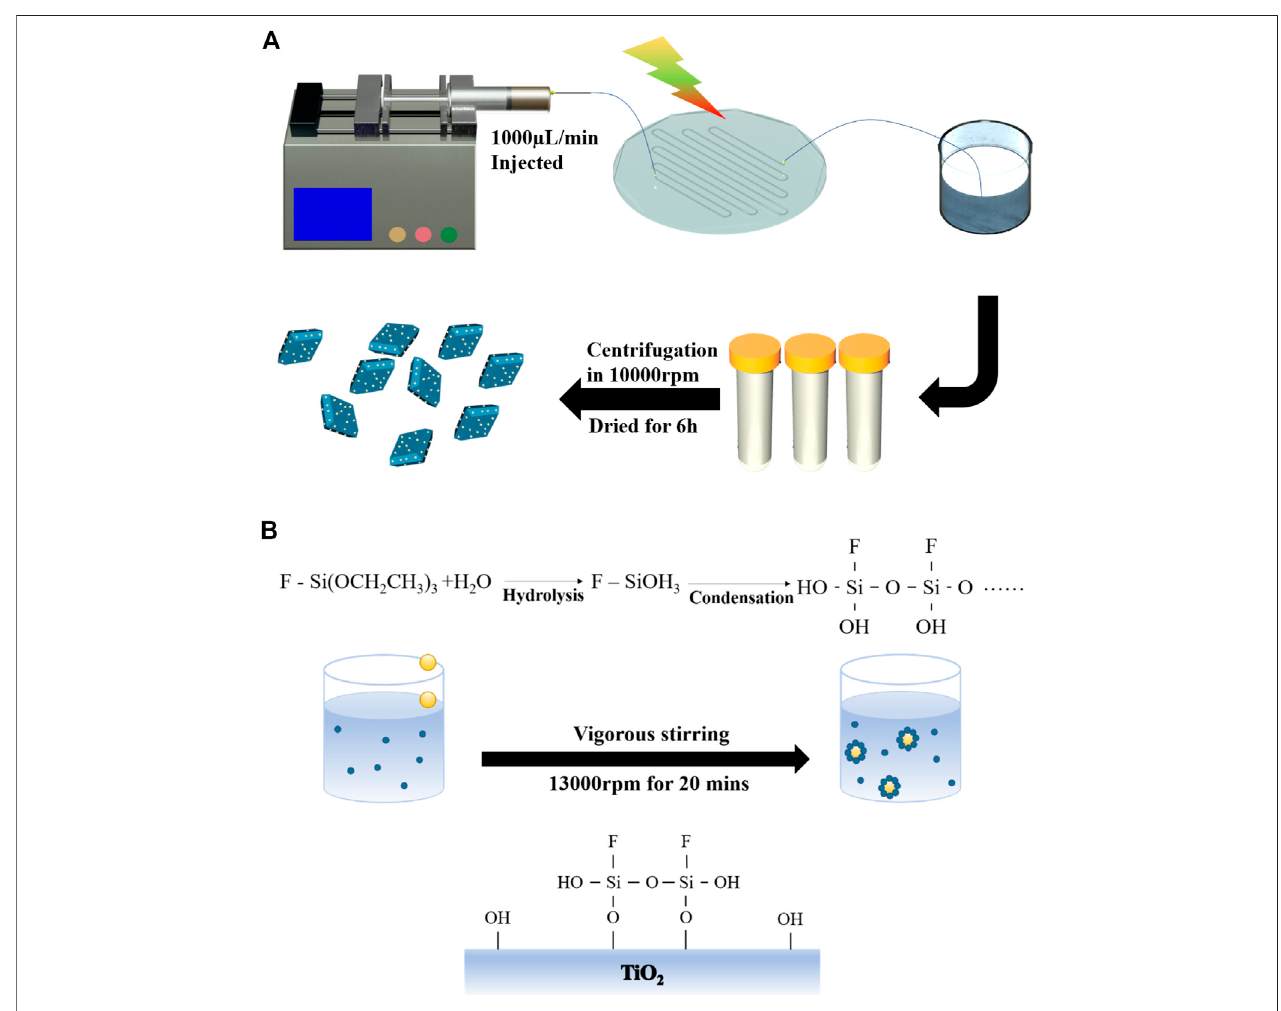
FIGURE 1 | Fabrication of Janus-type Pt/TiO 2 nanosheets: (A) ultrafast and highly dispersed loading of Pt on TiO 2 nanosheets using micro fl uidic technology; (B) selective surface modi fi cation of Pt/TNS.